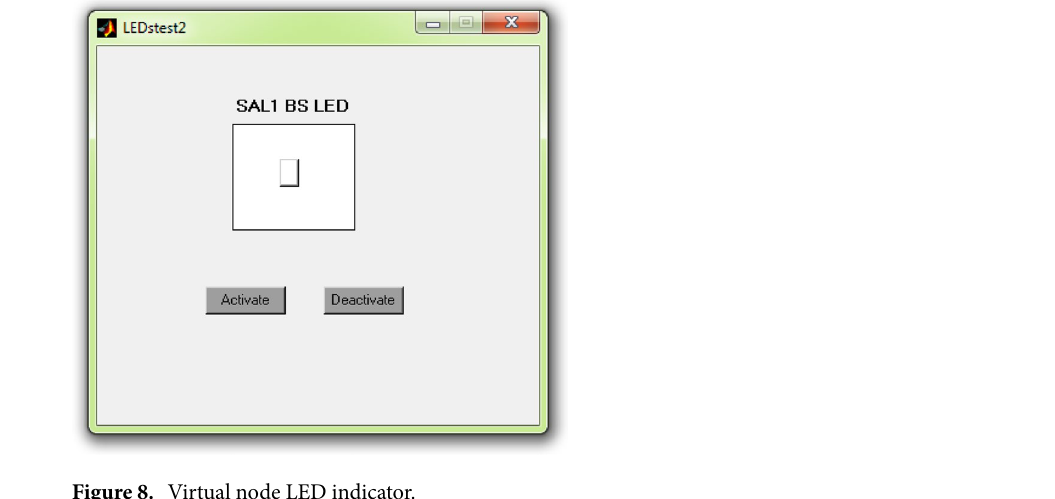
Figure 8. Virtual node LED